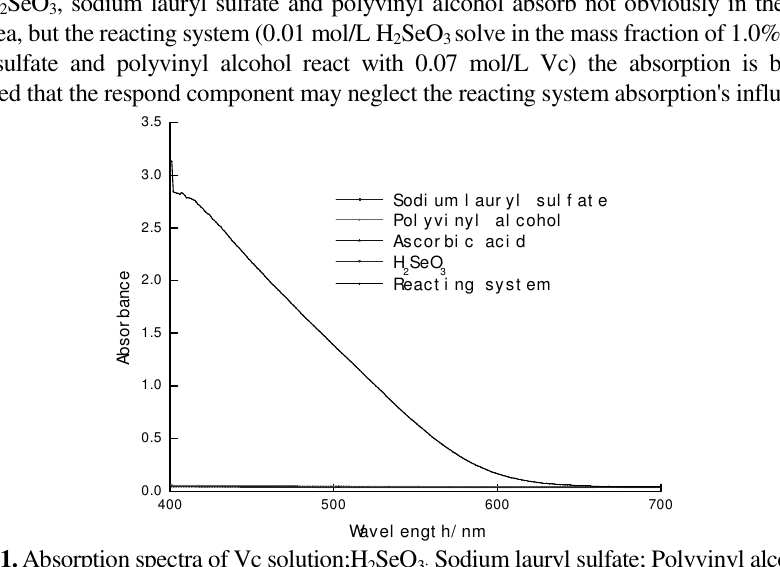
SeO Sodium lauryl sulfate; Polyvinyl 2 3;